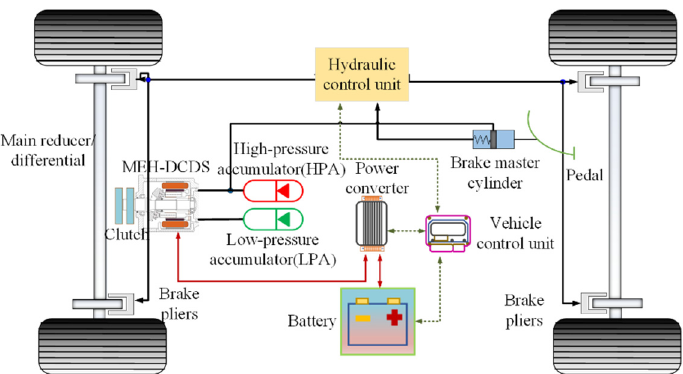
Figure 2. Structure of an electrohydraulic-power-coupled electric vehicle.